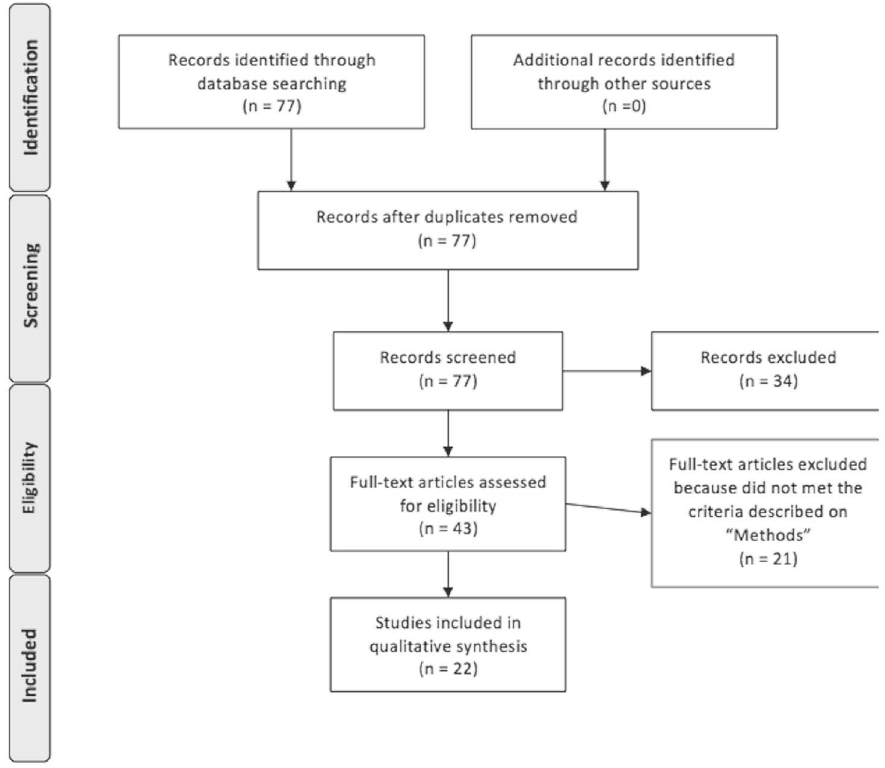
Figure 1. Decision process of the selection of the studies included in this review. Adapted from: Moher D, Liberati A, Tetzlaff J, Altman DG, The PRISMA Group (2009). Preferred Reporting Items for Systematic Reviews and Meta-Analyses: The PRISMA Statement. PLoS Med 6(6): e1000098. Doi:10.1371/journal.pmed1000097.